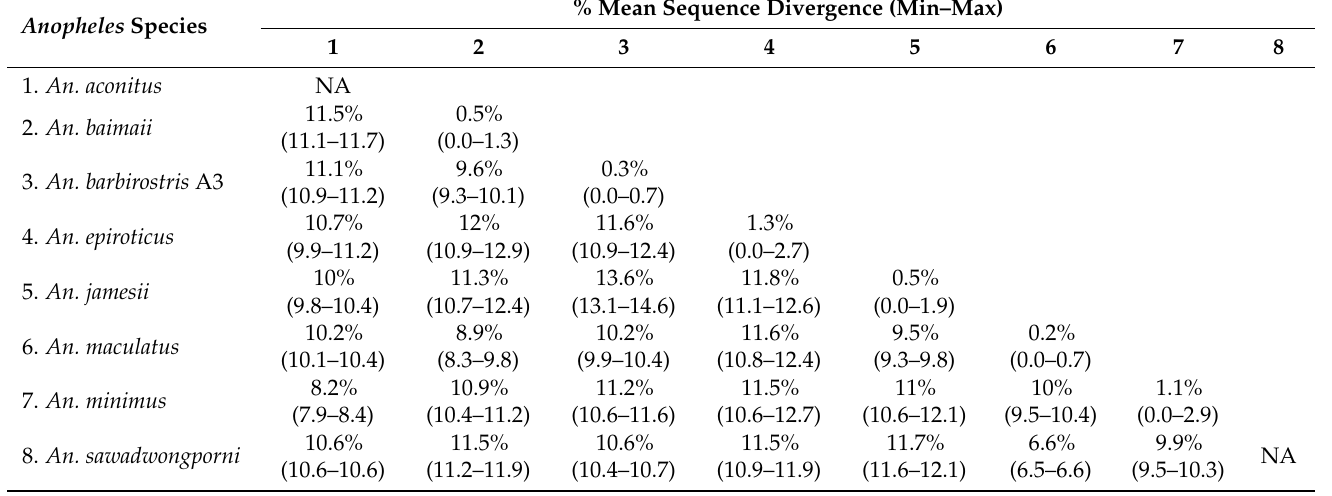
Table 3. Interspecific and intraspecific K2P genetic distances of Anopheles species were collected based on COI sequences in this